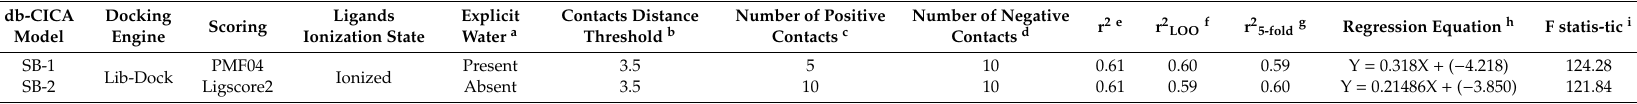
Table 1. Highest ranking docking-based Comparative Intermolecular Contacts Analysis (dbCICA) models, their corresponding parameters, and statistical criteria.